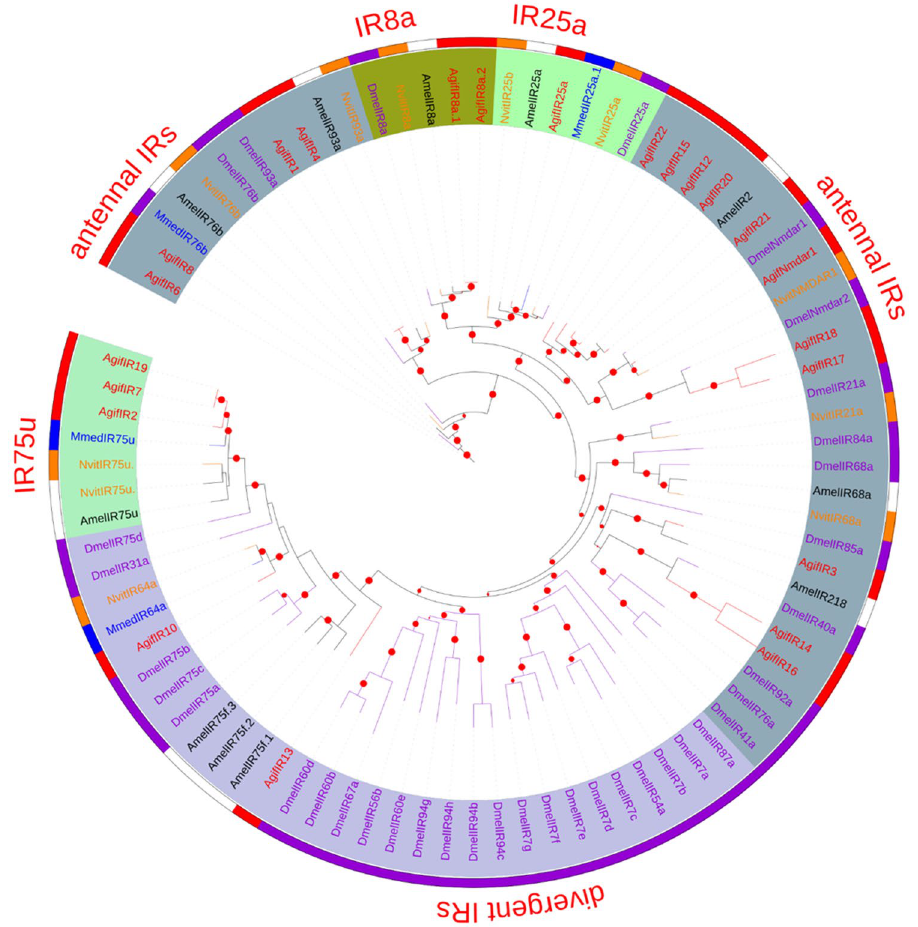
Figure 6. Maximum likelihood phylogenetic tree of ionotropic receptors (IRs). Included are ORs from Aphidius gifuensis (Agif), Microplitis mediator (Mmed), Apis mellifera (Amel), Drosophila melanogaster (Dmel), and Nasonia vitripennis